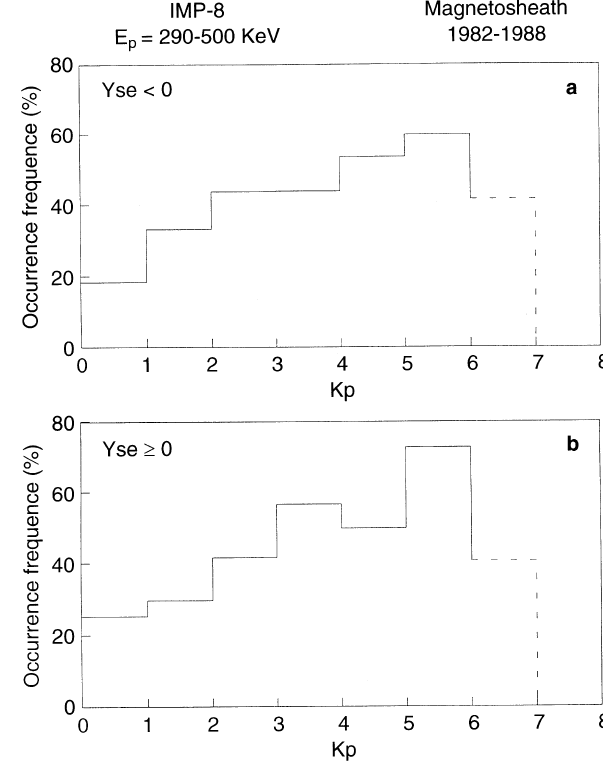
Fig. 1a,b. Maximum counting rate of the 290–500 keV ions as a function of the index Kp for the a dawn and b dusk magnetosheath. A strong correlation is evident between the counting rate of the high energy ions and the level of the geomagnetic activity